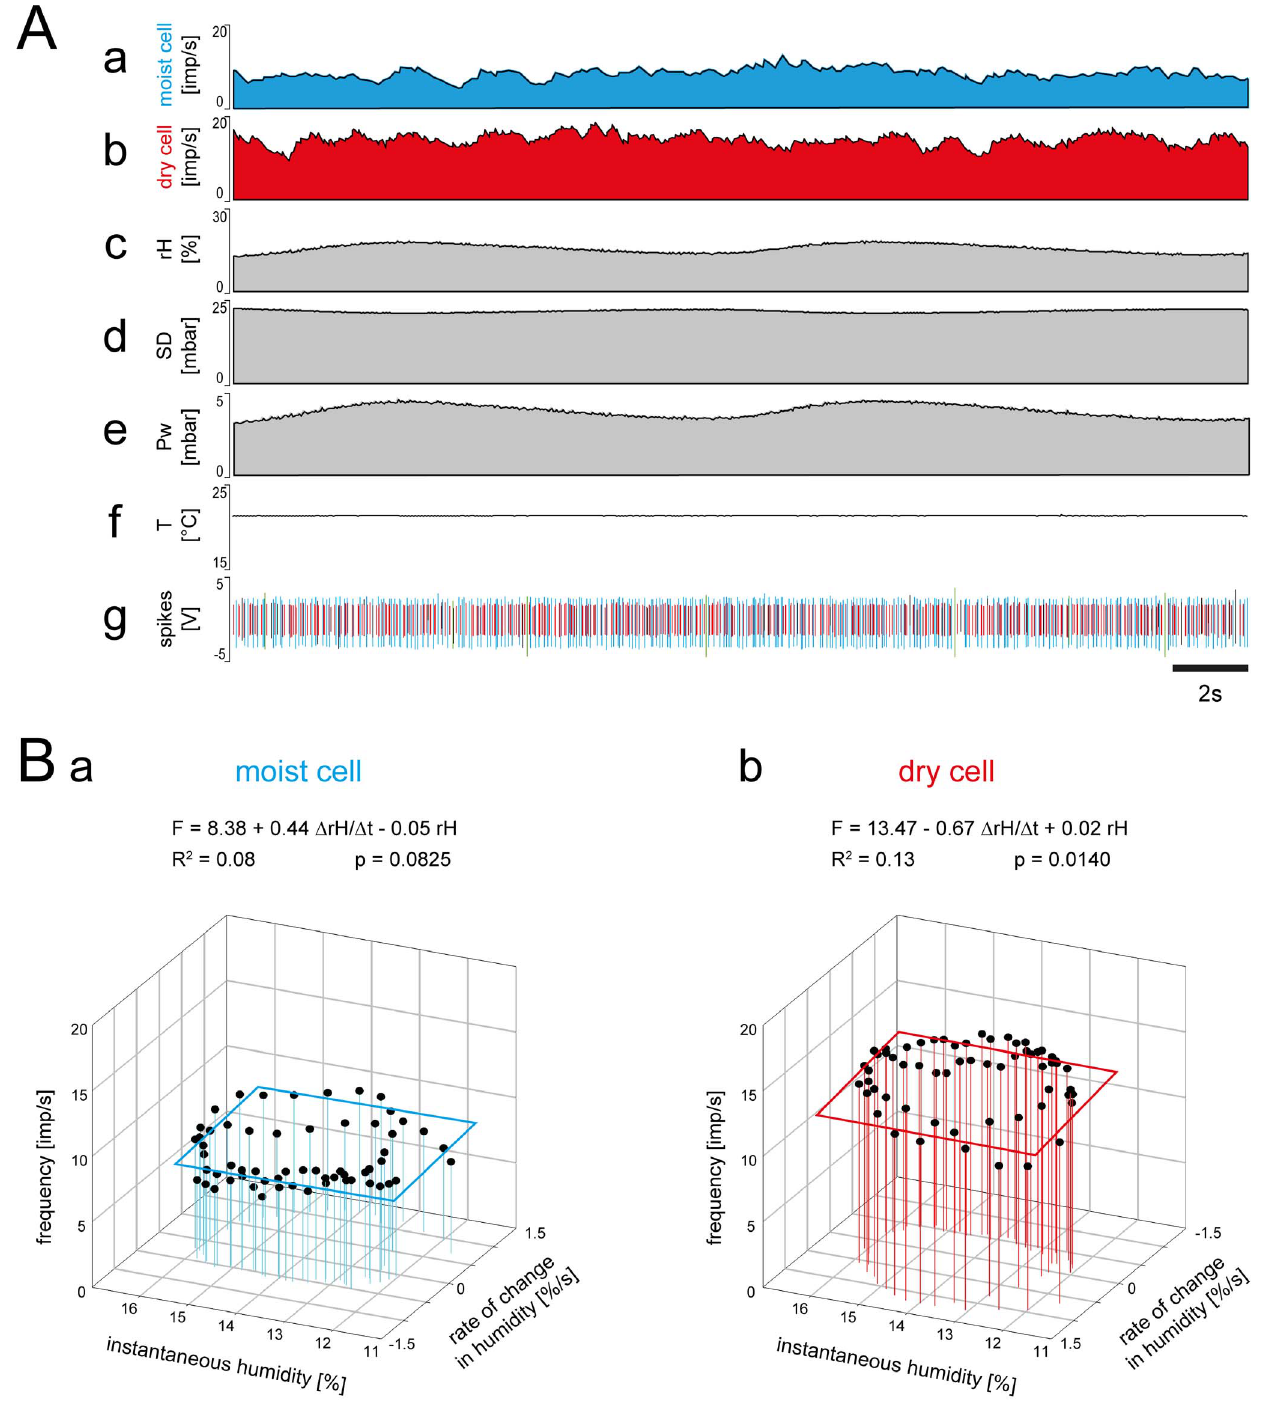
Figure 7. Simultaneously recorded responses of a pair of moist and dry cells from a single sensillum to small amplitude changes in humidity. A. Time course of the responses and the parameters controlled during the recording, and the corresponding activity of the moist and dry cells. a and b , instantaneous impulse frequency of both cells. c , time course of the relative humidity. d , time course of the saturation deficit. e , time course of the water vapor pressure. f , time course of the temperature. g , digitized action potentials of the moist and dry cells recorded with a single electrode and discriminated on-line. B. Impulse frequency of the moist and dry cells during the oscillations in relative humidity shown in A plotted as a function of instantaneous relative humidity and its rate of change. Multiple regressions which utilize 3-dimensional planes ( F = a + b drH/dt + c rH ; where F is the impulse frequency, and a the height of the regression plane) were calculated to determine the simultaneous effects of the rate of change in the relative humidity ( b slope) and the instantaneous relative humidity ( c slope) and the response frequency of both cell types. Pw water vapor pressure, R 2 coefficient of determination, rH relative humidity, SD saturation deficit, T temperature, V volt.